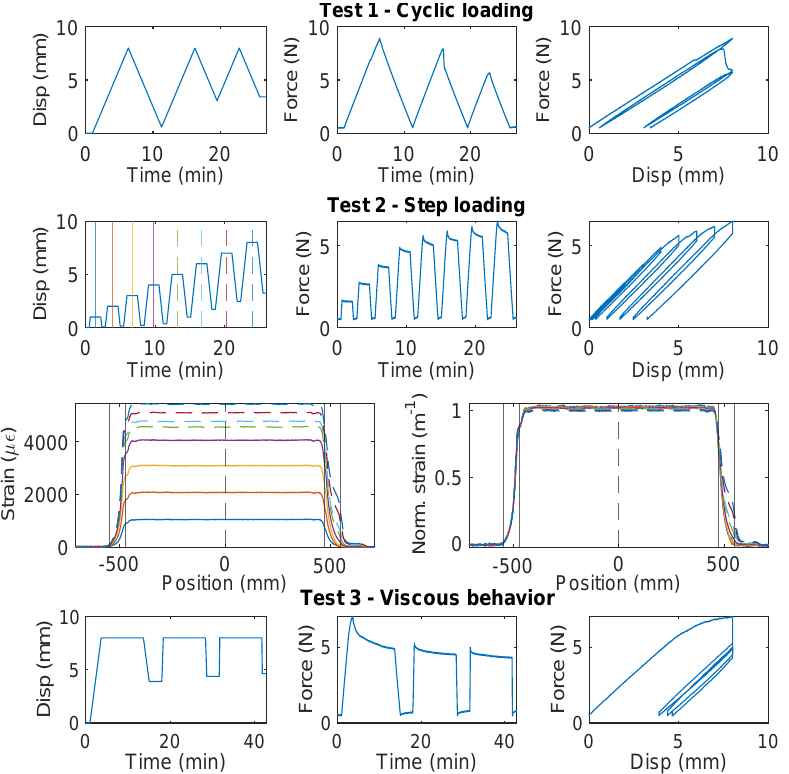
Figure 10. The loading protocol, force–displacement relation and strain distributions under increasing displacement levels (represented by different color lines) for Specimen 2 of the PVC 0.9 mm